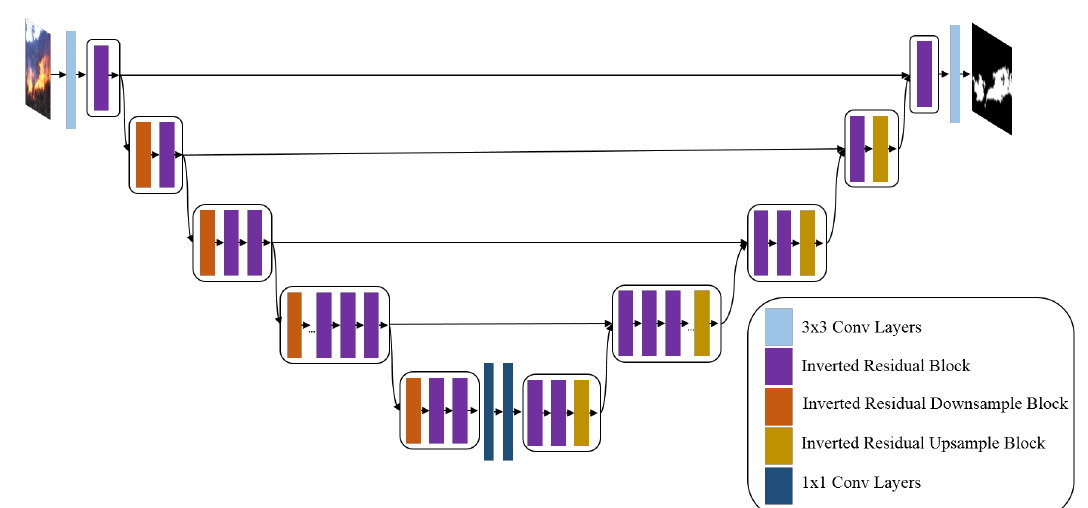
Figure 4. The proposed EfficientSeg architecture.